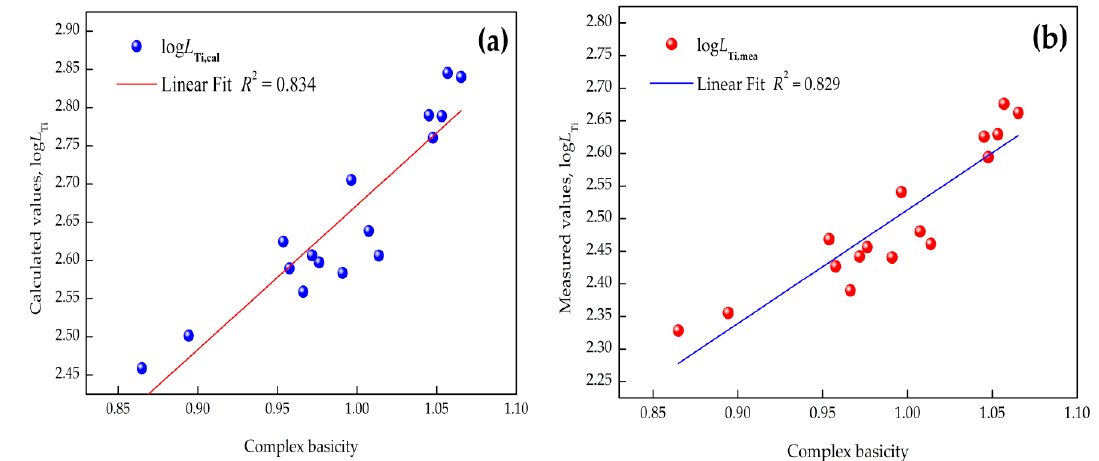
Figure 4. Correlation between complex basicity and titanium distribution ratio: ( a ) calculated by IMCT; ( b ) industrial measurements.